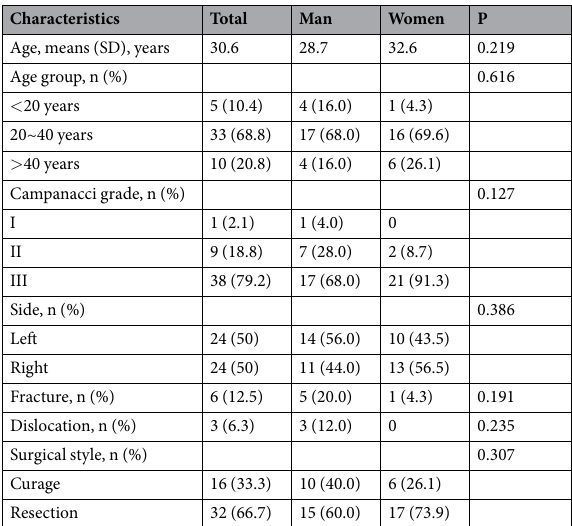
Table 2. Clinical characteristics of primary GCT of the distal radius by gender.